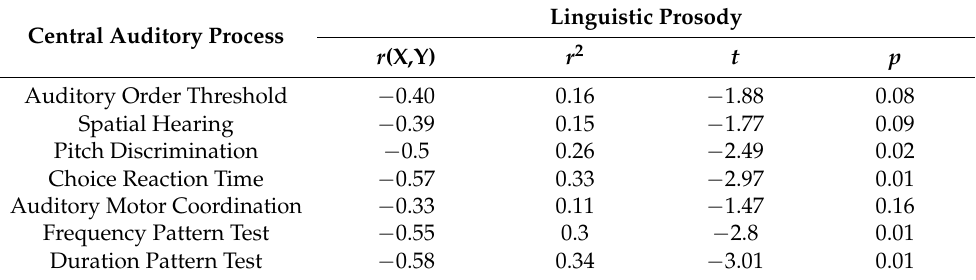
Table 5. Auditory low-level function and linguistic prosody. Linguistic Prosody Central Auditory Process r (X,Y) r 2 t p Auditory Order Threshold − 0.40